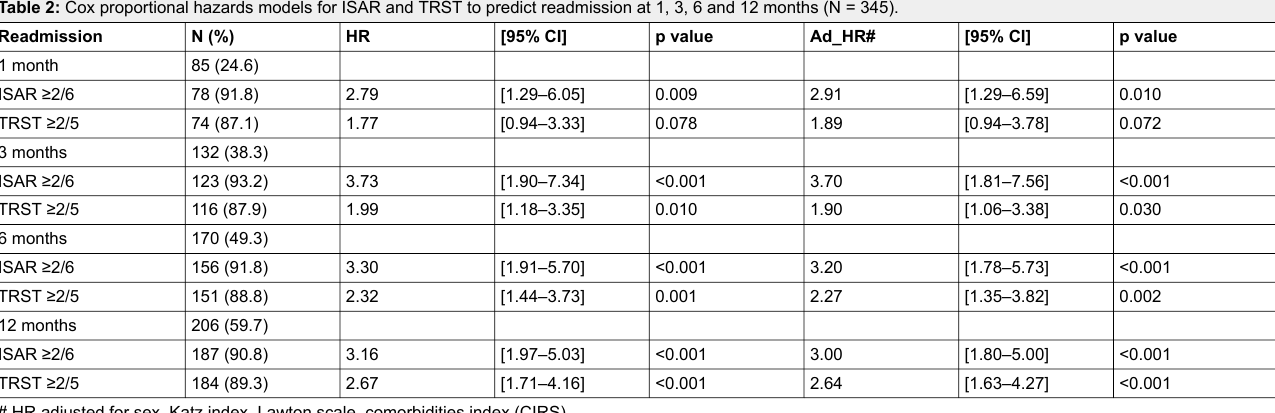
Table 2: Cox proportional hazards models for ISAR and TRST to predict readmission at 1, 3, 6 and 12 months (N = 345).